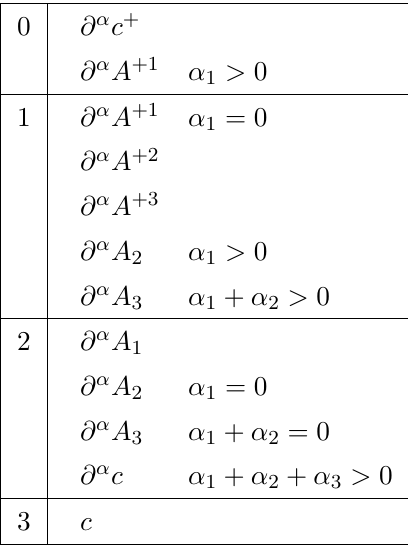
Table 1 . Filtration of jet